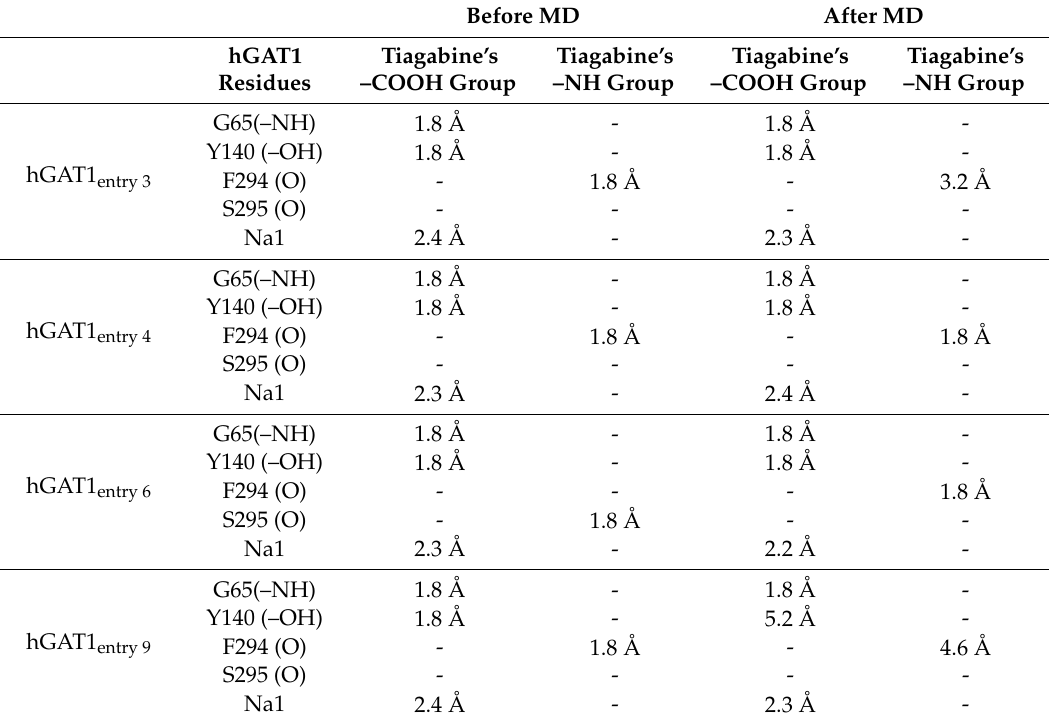
Table 4. Ligand–protein interaction profiles of the selected hGAT1–tiagabine complexes before and after 100 ns of MD